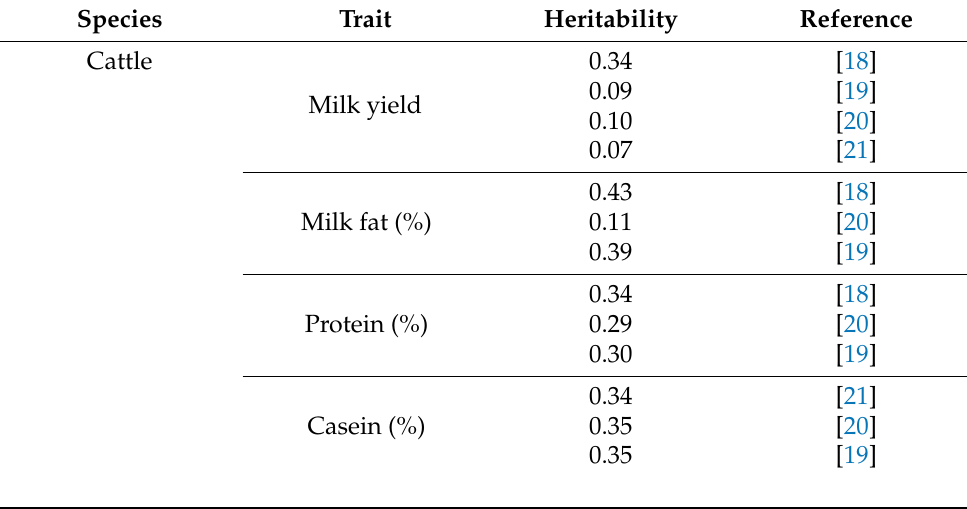
Table 1. Heritability estimates for milk production traits in cattle.